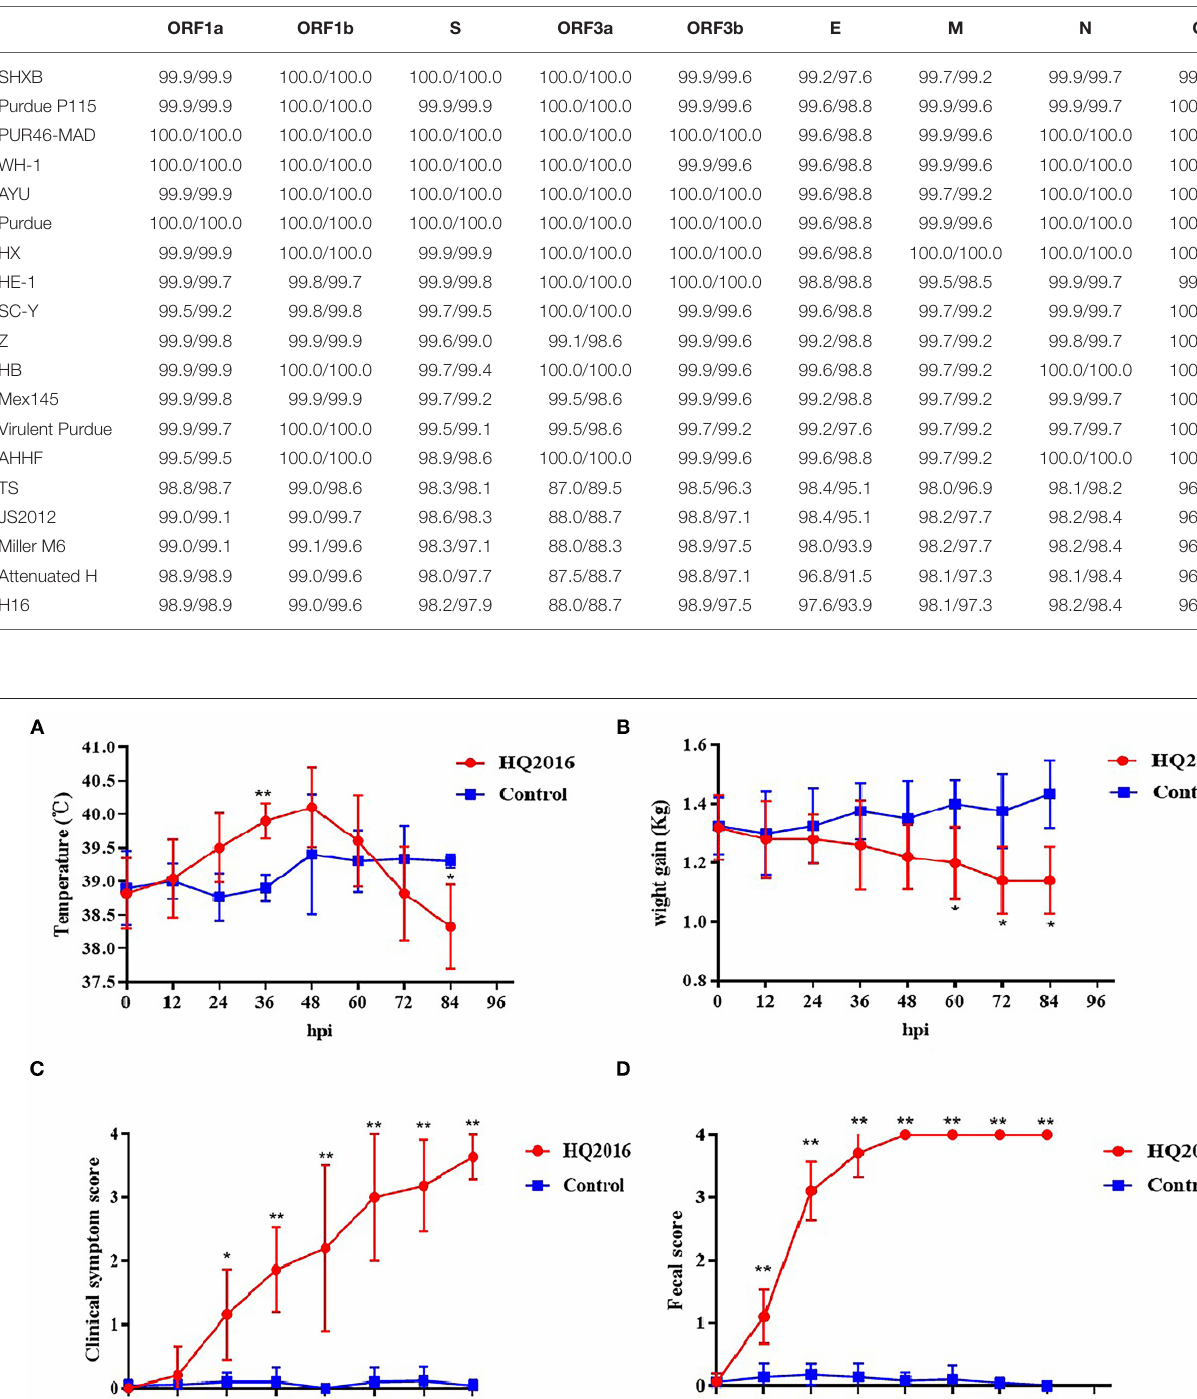
TABLE 4 | Nucleotide and amino acid sequence identities (%) of TGEV HQ2016 strain compared with other 19 TGEV strains.